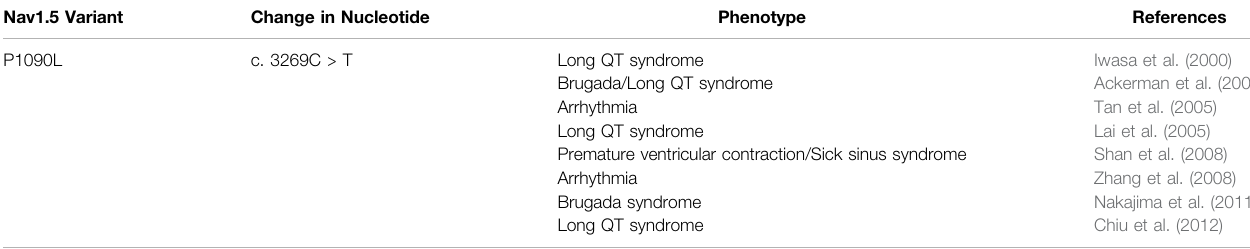
TABLE 1 | Summary of citations for the Na v 1.5 mutation P1090L associated with cardiac arrhythmias. Nav1.5